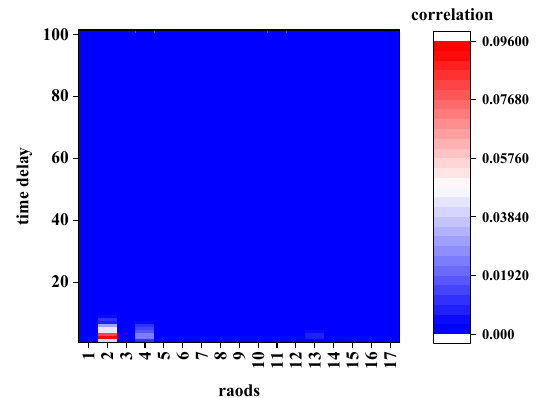
Figure 11. Correlation determined using the DCF.